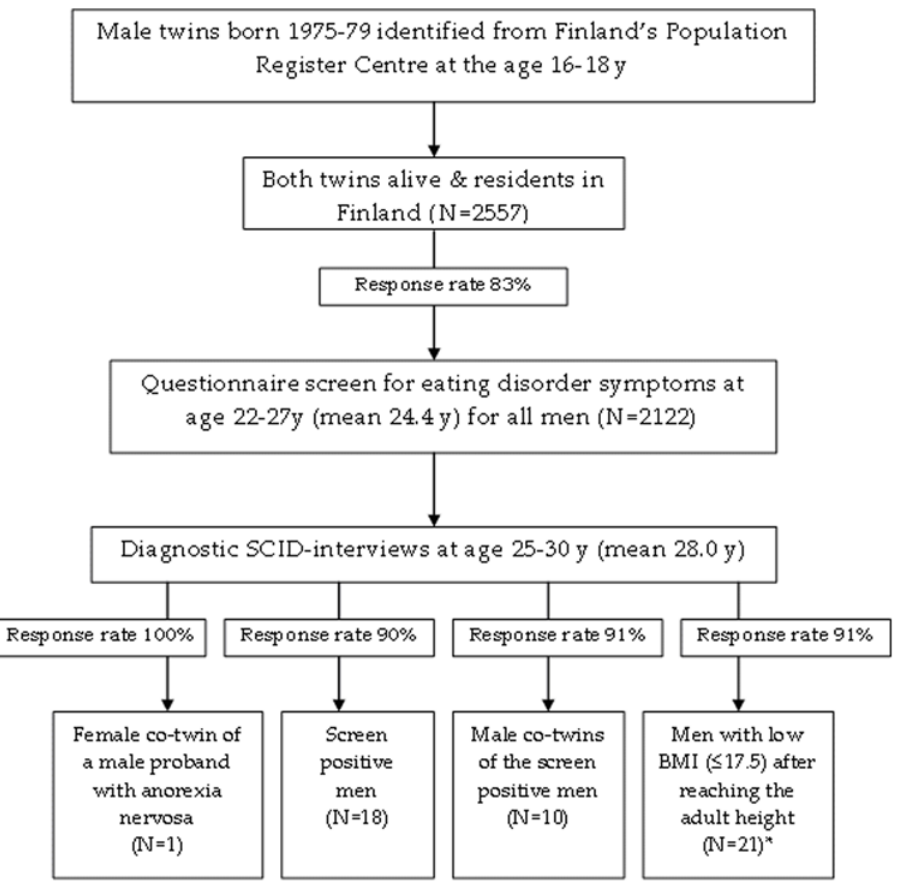
Figure 1. Flow chart of the data collection of eating disorder study in males of FinnTwin16 cohorts. * Excluded N=10 men whose low BMI resulted from missing limbs or tetraplegia; or other severe physical illness (multiple sclerosis, cerebral palsy).